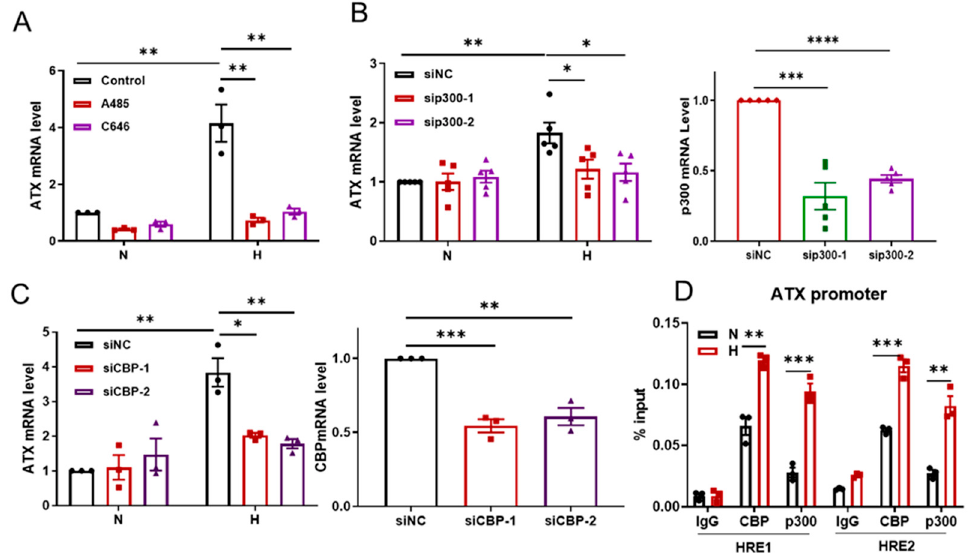
Figure 5. p300/CBP participates in ATX induction during hypoxia. ( A ) SW480 cells were cultured under normoxic (N) or hypoxic (1% O 2 , H) conditions with A485 (200 nM) or C646 (25 µM) treatment for 24 h. ATX mRNA levels were detected using RT-qPCR. ( B , C ) SW480 cells were transfected with p300 siRNA or CBP siRNA and then cultured under normoxic (N) or hypoxic (1% O 2 , H) conditions for 24 h. ATX, CBP, or p300 mRNA levels were detected with RT-qPCR. ( D ) SW480 cells were cultured under hypoxic conditions for 24 h and then subjected to ChIP assays with an anti-CBP antibody or an anti-p300 antibody to detect the binding abilities of CBP and p300 to HRE1 or HRE2, respectively. IgG was used as a control. And the data shown are the mean ± SEM of n = 3/5 independent experiments. p -values were calculated with a two-way ANOVA with Tukey’s t test ( A – C ) and two-sided